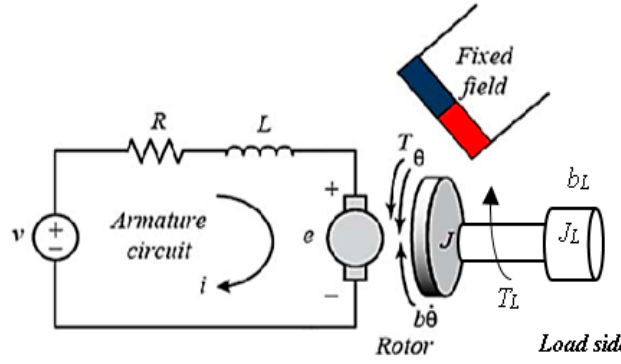
Figure 1. Schematic diagram of the permanent magnet DC (PMDC) motor.